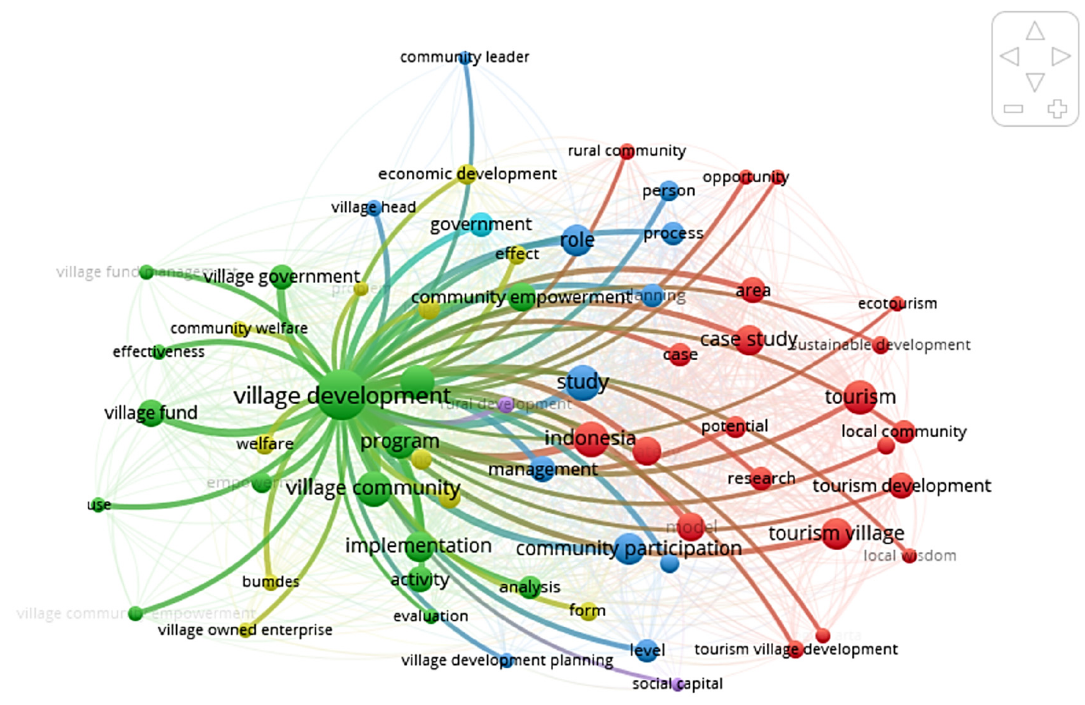
Figure 1. Mapping of research results for village development system innovation.